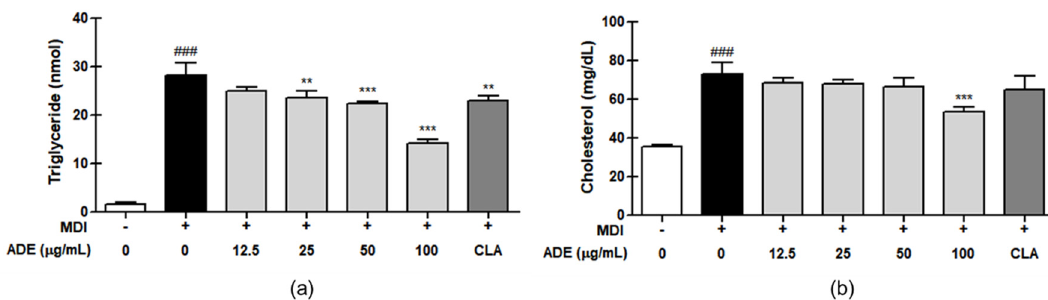
Figure 2. Effect on triglyceride ( a ) and cholesterol contents ( b ) of ADE. Differentiating 3T3-L1 adipocytes were treated with every 2 days with extracts (25–100 μ g/mL) for 8 days in adipocyte-induction media. CLA (50 μ M) was a positive control. All values are means ± SD ( n = 3).